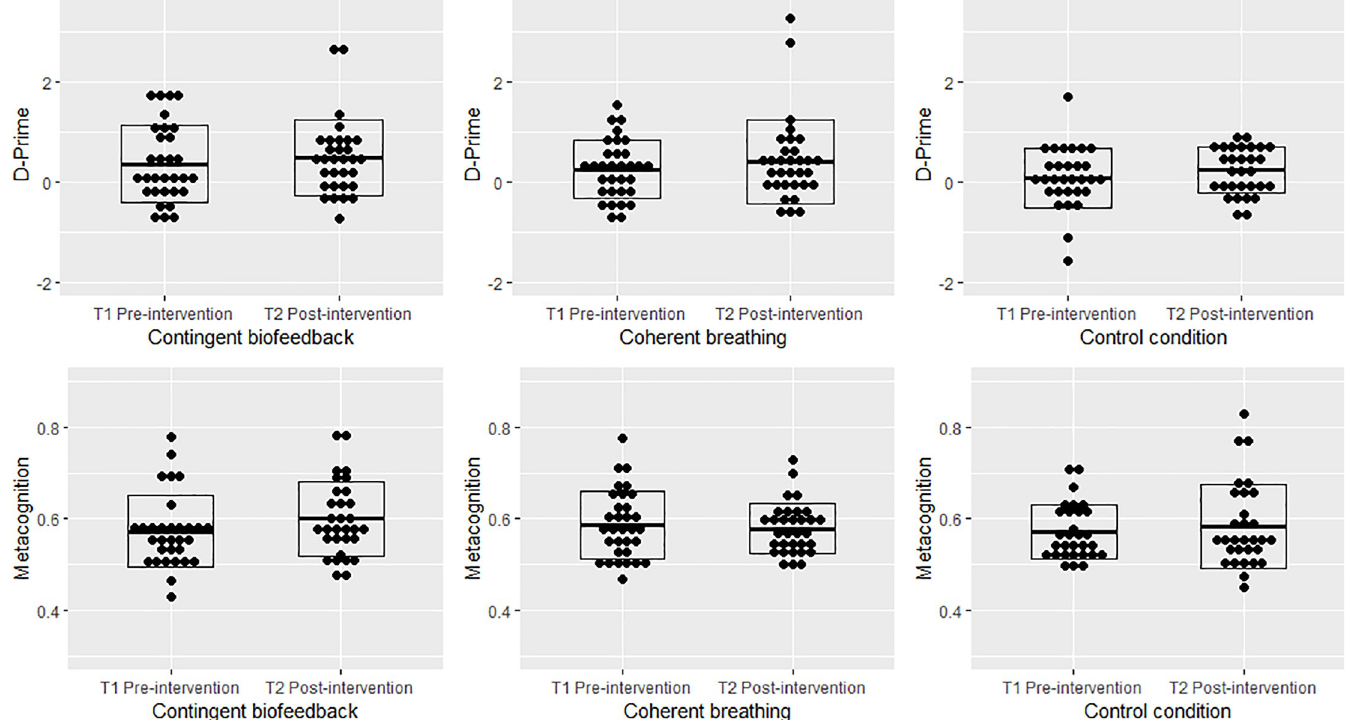
Fig 3. Interoceptive accuracy assessed with the heartbeat discrimination task from pre- to post-intervention (top row), separately for all the three groups (contingent biofeedback, coherent breathing, and control condition), which did not differ significantly from each other. Similar results are depicted for metacognitive performance (area under the type II receiver operating characteristic curve; bottom